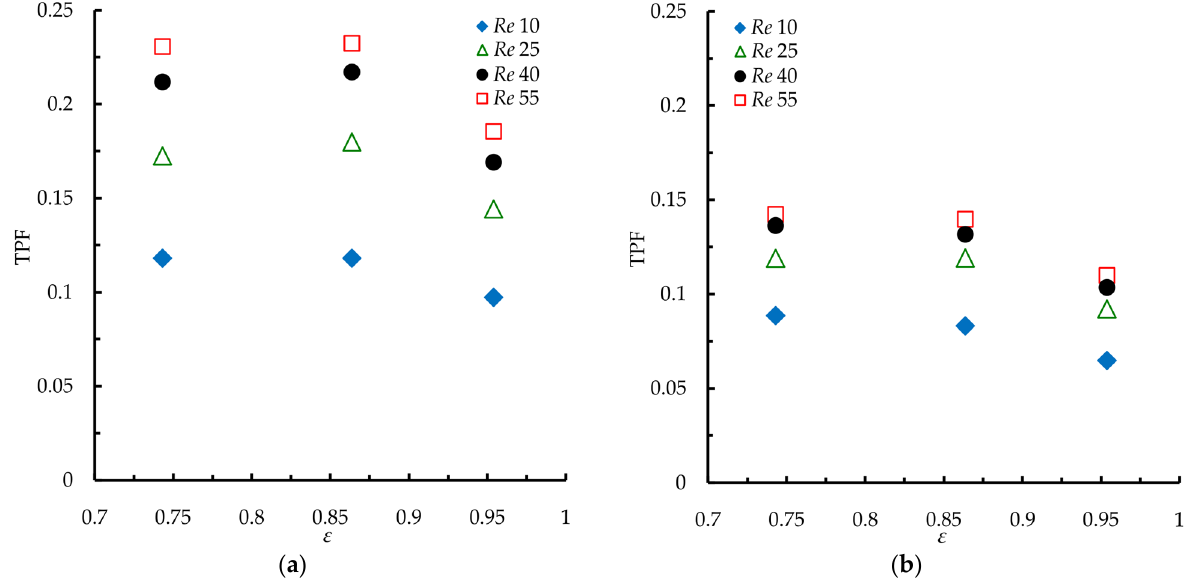
Figure 18. The effect of the porosity on the Thermal Performance Factor averaged over one period of pulsation for different duty cycles: ( a ) ψ = 0.25, ( A / D s ) St = 0.268. ( b ) ψ = 0.5, ( A / D s ) St = 0.268.